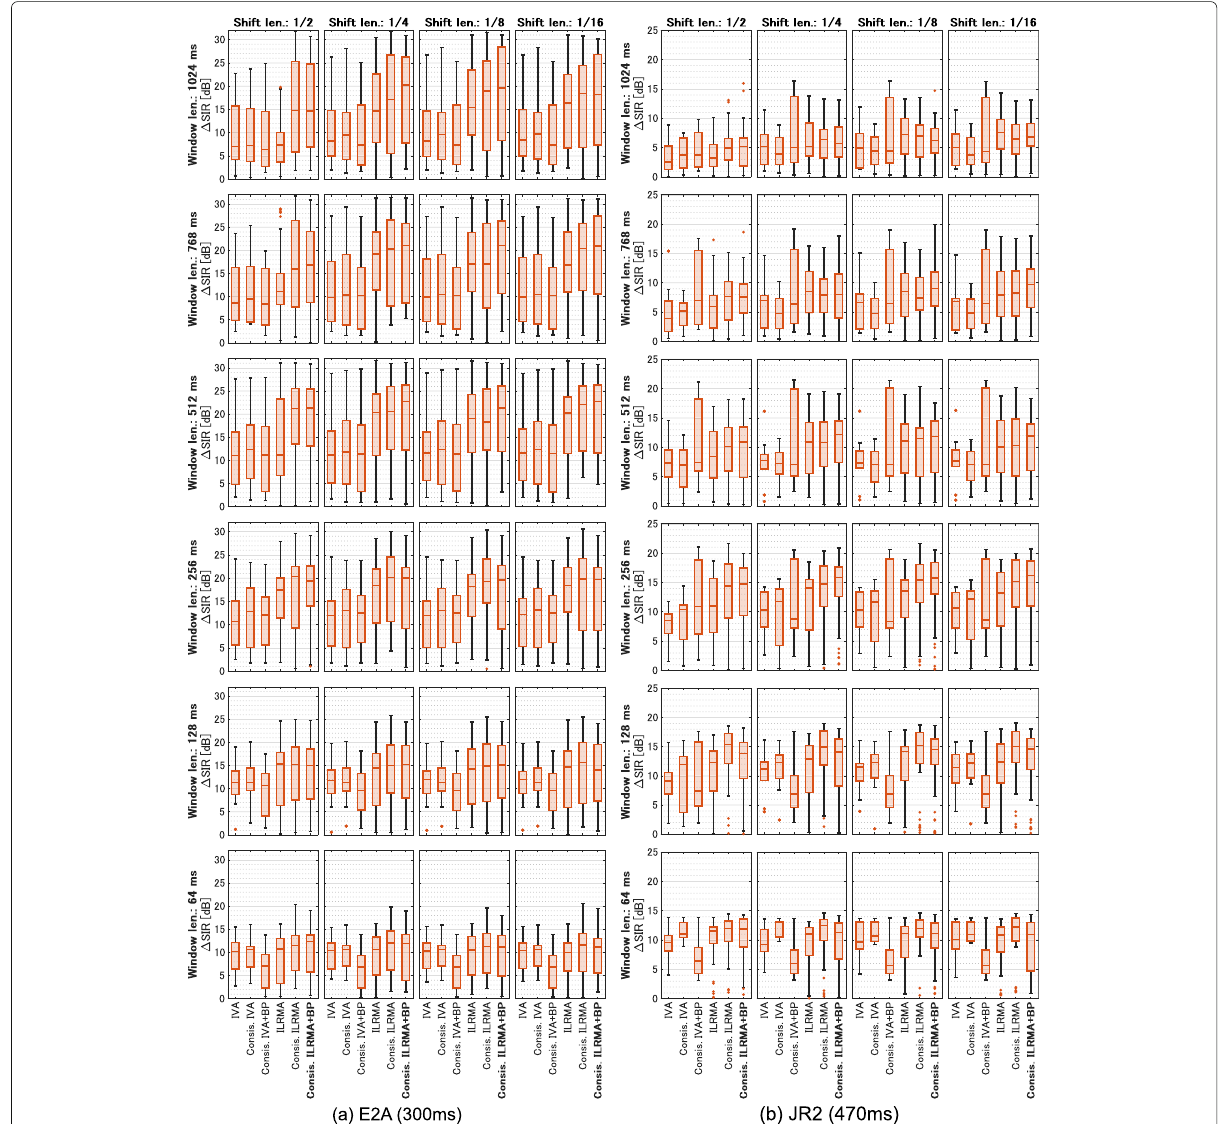
Fig. 17 Average SIR improvements for synthesized music mixtures (music 1–10) with a E2A and b JR2 , where Hamming window is used in